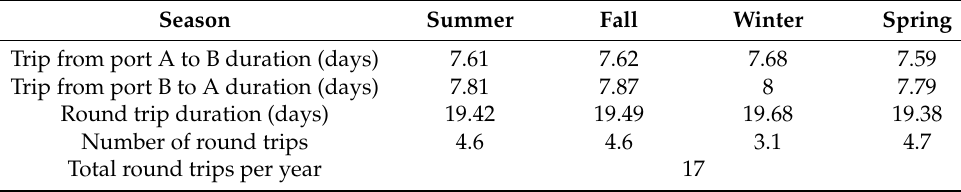
Table 28. Trip durations and round trips per season.